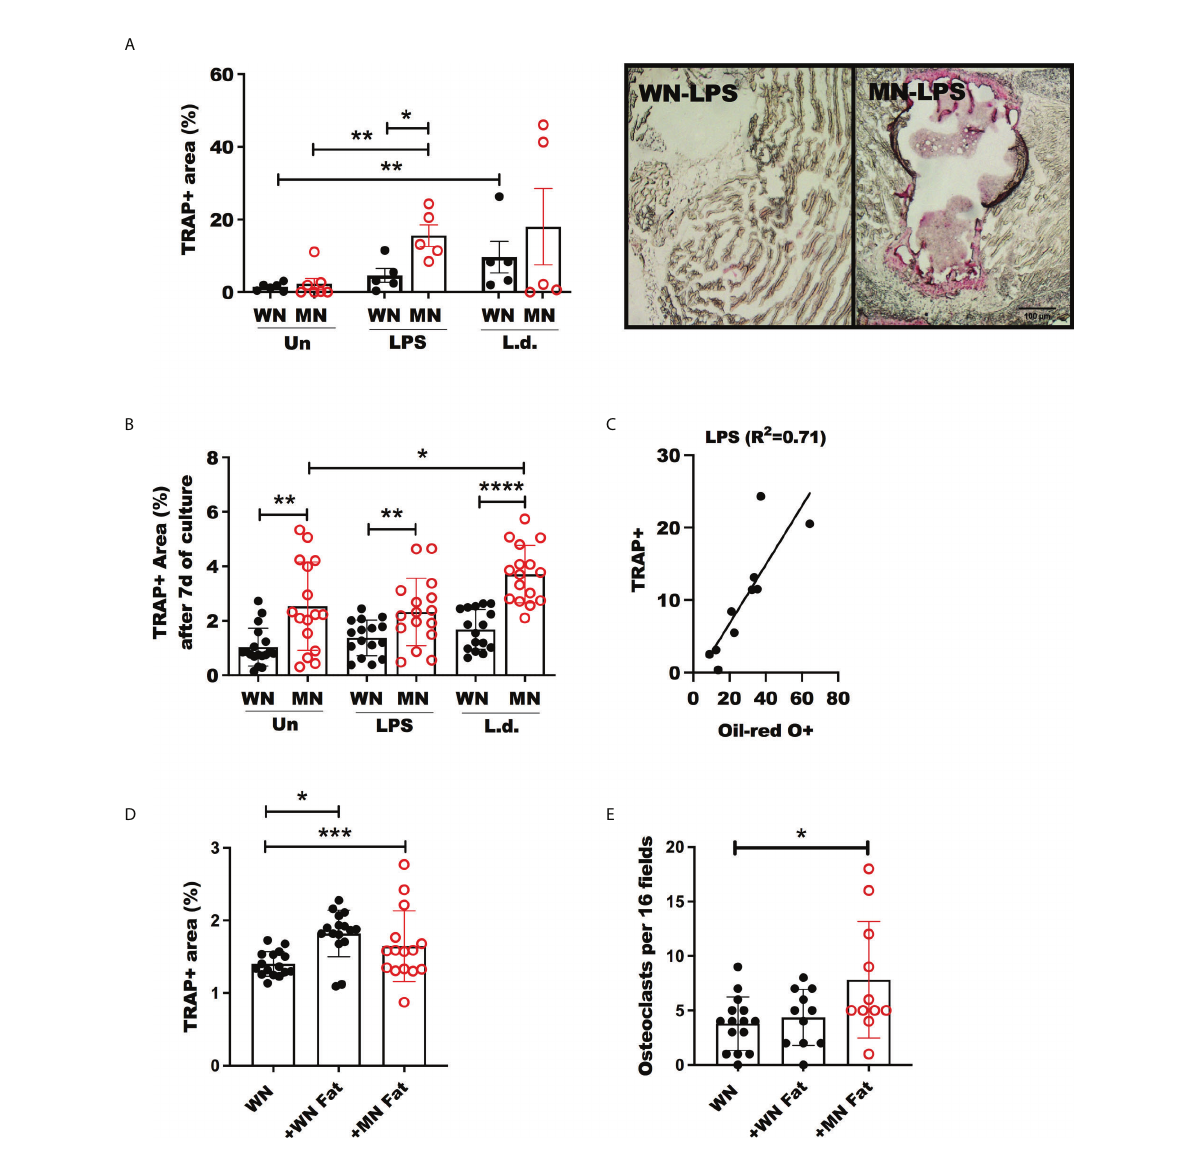
FIGURE 5 Increased Osteoclast activity in malnourished mice following in fl ammatory challenge. Well-nourished (WN) or malnourished mice (MN) remained naive unchallenged (Un) or were challenged with LPS or L. donovani ( Ld ). (A) Osteoclast activity measured by tartrate resistant acid phosphastase (TRAP) positive area in sternum cryosections and image showing TRAP staining (pink areas) of sternum cryosections from LPS challenged mice (same magni fi cation for both panels). n=5 mice per groug, 2 experiments. (B) Percentage of area occupied by TRAP+ osteoclasts from femur bone marrow differentiated ex vivo with m-Csf and Rankl with or without exposure to LPS or L. donovani antigens ( L.d. ). (C) Linear correlation and correlation coef fi cient (R 2 ) of TRAP+ area vs. oil-red-O+ area in sternum cryosections of LPS-challenged mice. (D, E) Percentage of area occupied by TRAP+ osteoclasts and number of osteoclasts per fi eld from bone marrow femur of well-nourished mice (WN) differentiated with ex vivo with M-CSF and RANKL with or without exposure to 6mg/mL fat homogenate from well-nourished (+WN fat) or from malnourished mice (+MN fat). Number of multinucleated osteoclasts by Methyl green staining. Representative of 2 experimets with cells pooled from 2-3 mice/group. *p<0.05, **p<0.01, ***p<0.001,